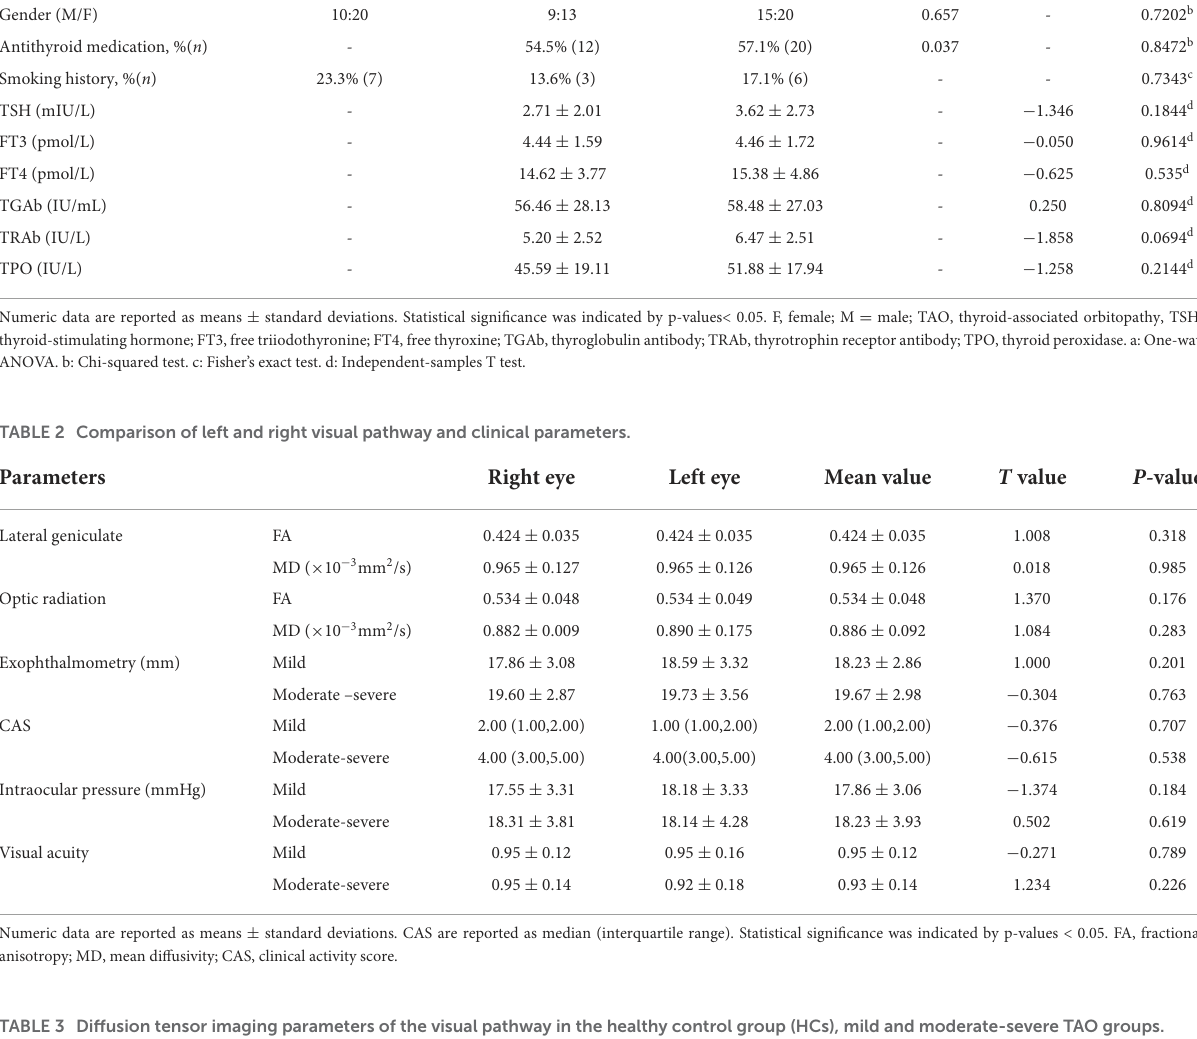
TABLE 3 Diffusion tensor imaging parameters of the visual pathway in the healthy control group (HCs), mild and moderate-severe TAO groups.